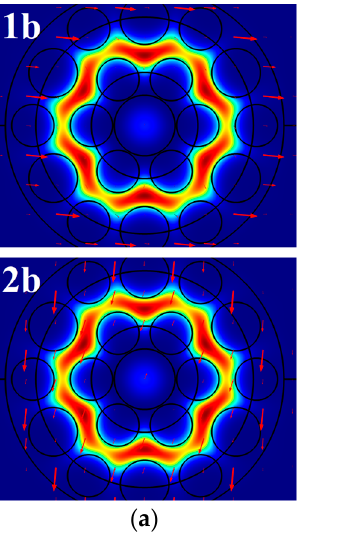
Figure 3. ( a ) Spatial intensity distributions of Modes 1b and 2b in the straight MOF-18 for a wave- length of 1.65 µm; ( b ) Spectral dependences of the leakage losses ( α 1a and α 1b ) and intensities ( I 1a and I 1b ) of Modes 1a and 1b in the straight MOF-18, and the resulting leakage loss for FM 1 ( α 1 ).